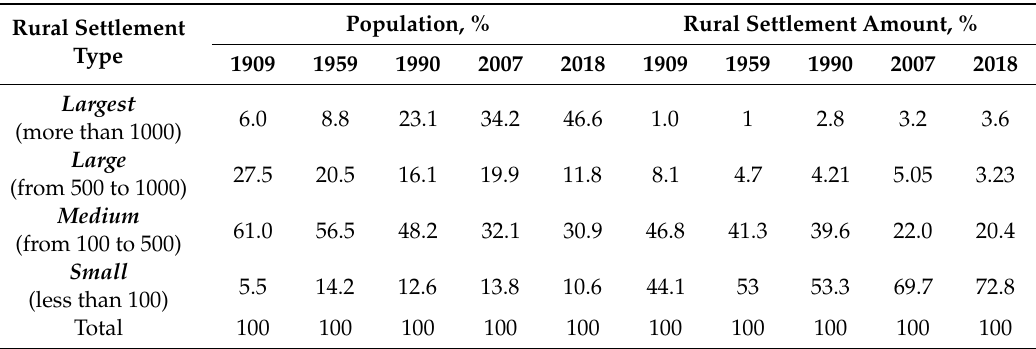
Table 4. Population and rural settlement amount (in relative units) within the current boundaries of the Mogilev district from 1909 to 2018.